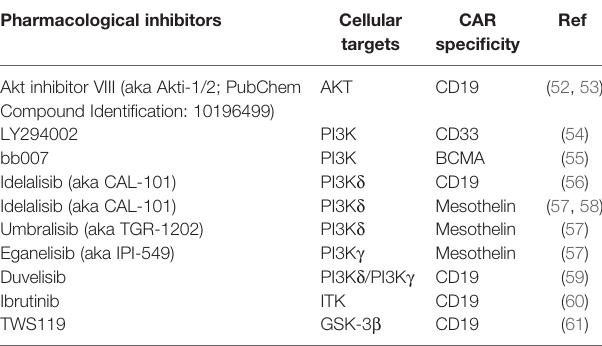
TABLE 4 | Summarization of studies on pharmacological inhibitors. Pharmacological inhibitors Cellular